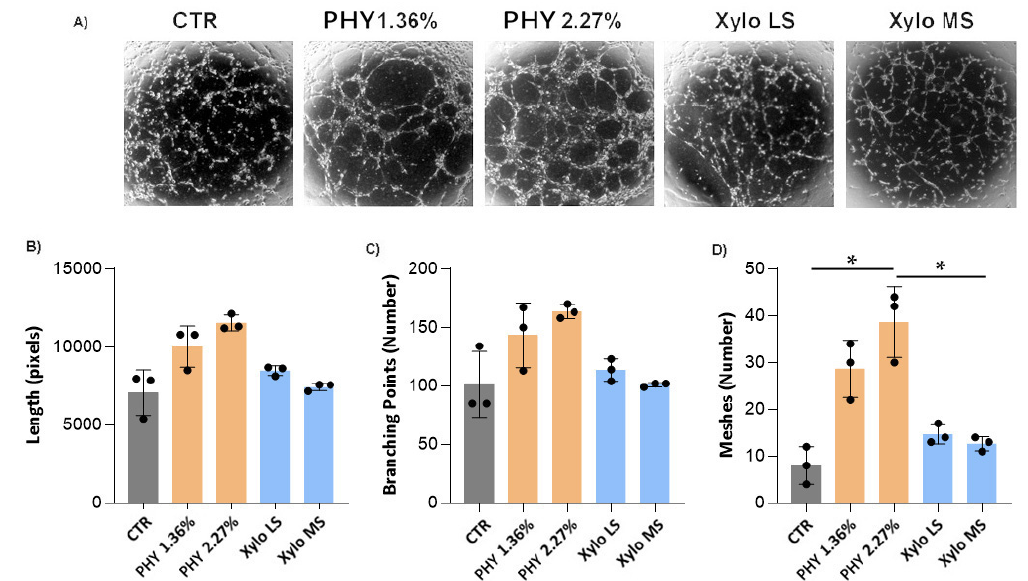
Figure 10. Angiogenesis assay. ( A ) The figure shows representative images of HUVEC endothelial cells, seeded on growth factor reduced matrigel, and cultivated in the presence of HMRSV5 mesothelial cell-conditioned medium. Morphometric characterization of the patterns generated by HUVEC cells on Matrigel is reported in the relative graphs. Data represent the dimensional [length ( B )] and topological [branching points ( C ) and meshes ( D )] parameters. Values are given as mean ± SD ( n = 3 biological replicates). ( D ) CTR vs. PHY 2.27% p = 0.0023, PHY 2.27% vs. Xylo MS p = 0.0046 * p < 0.05.